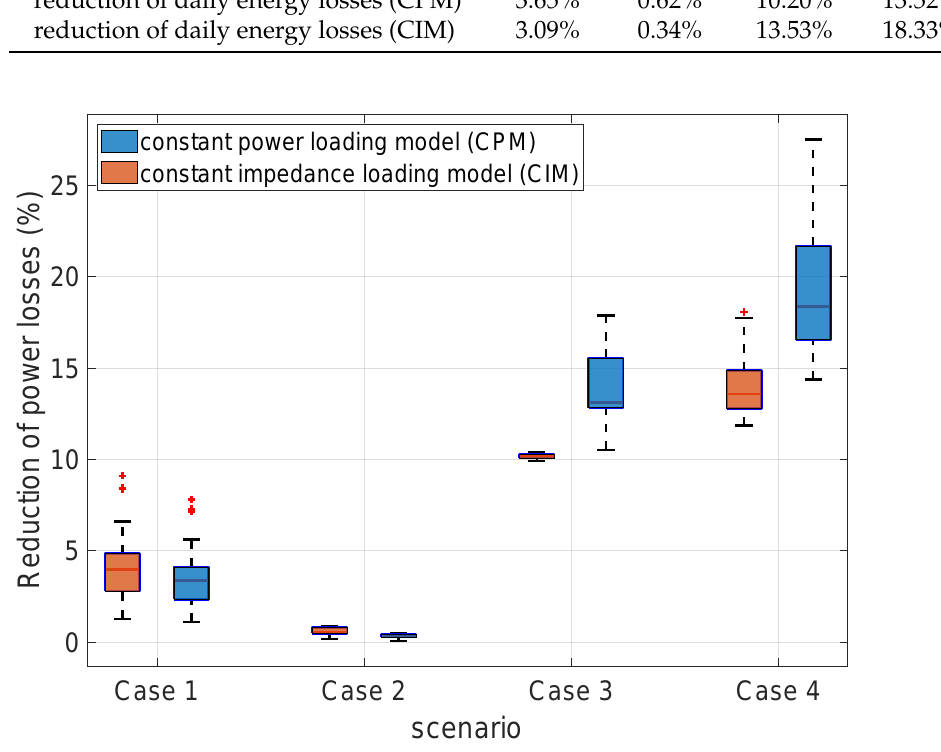
Figure 6. Distribution of hourly values of reduction in power